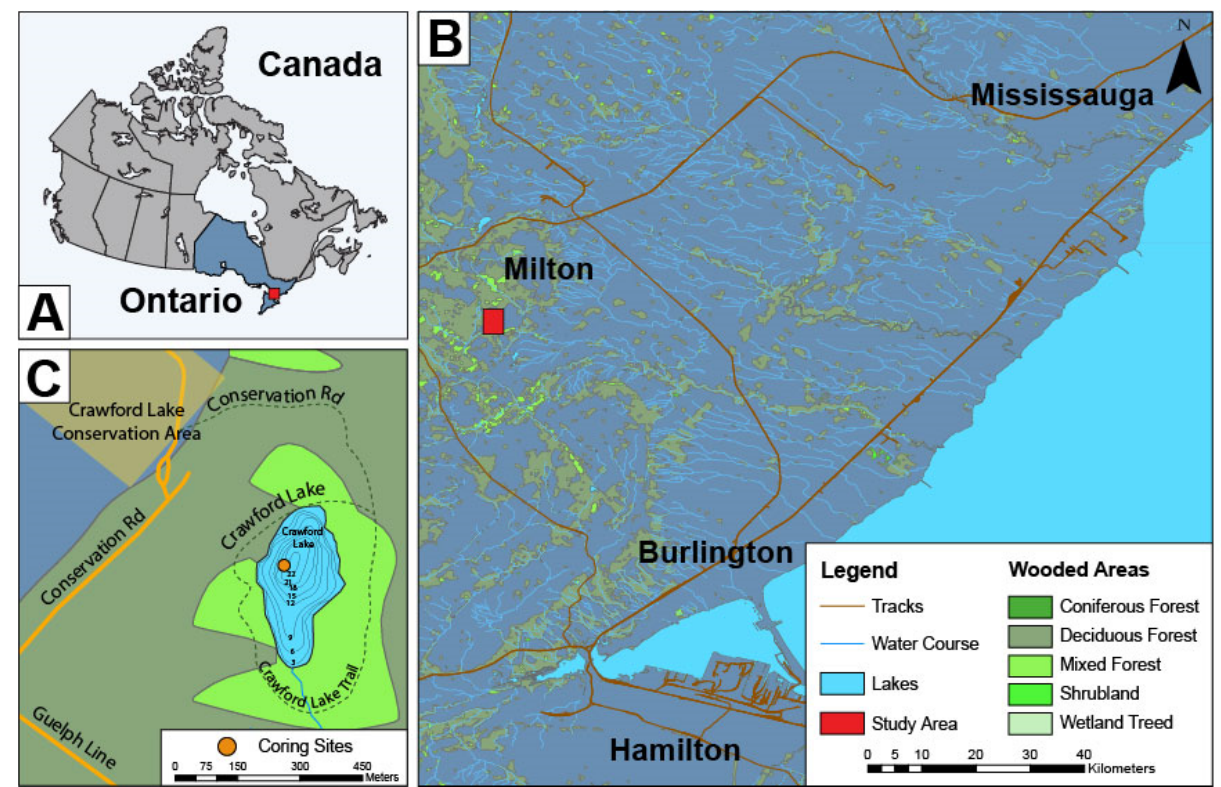
Figure 1. Location of Ontario, Canada ( A ), Crawford Lake, Milton location map ( B ) legend describes land use and vegetation. Crawford Lake coring site ( C ) within Crawford Lake Conservation Area, walking trail is shown with dotted line.